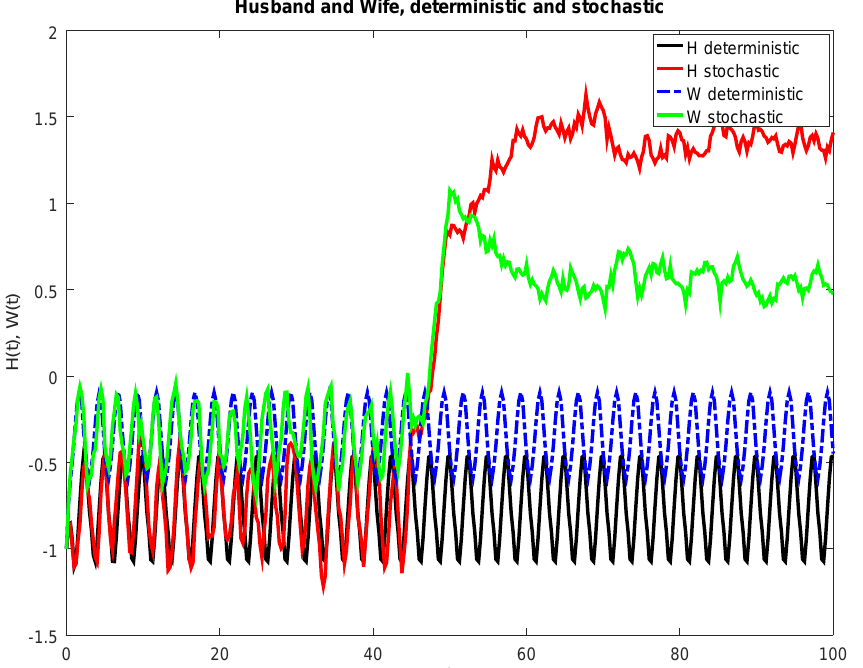
Figure 10. Piece-wise cubic influence functions. Plot of H and W vs. time for the deterministic case and a stochastic realization with initial values H 0 = − 1, W 0 = −